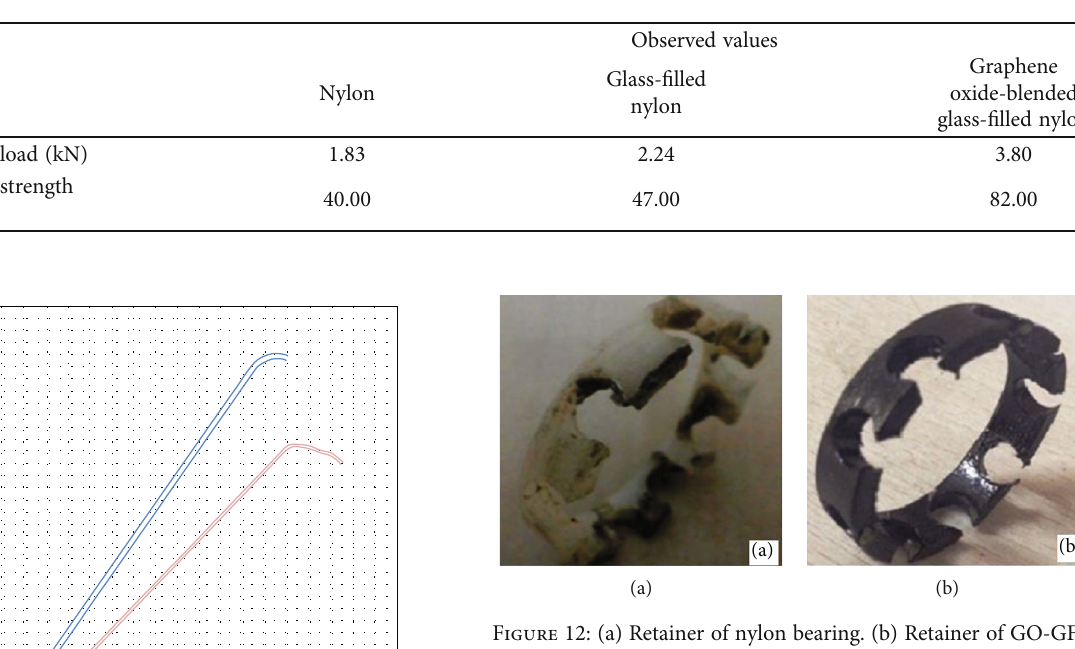
Table 5: Tensile test results.